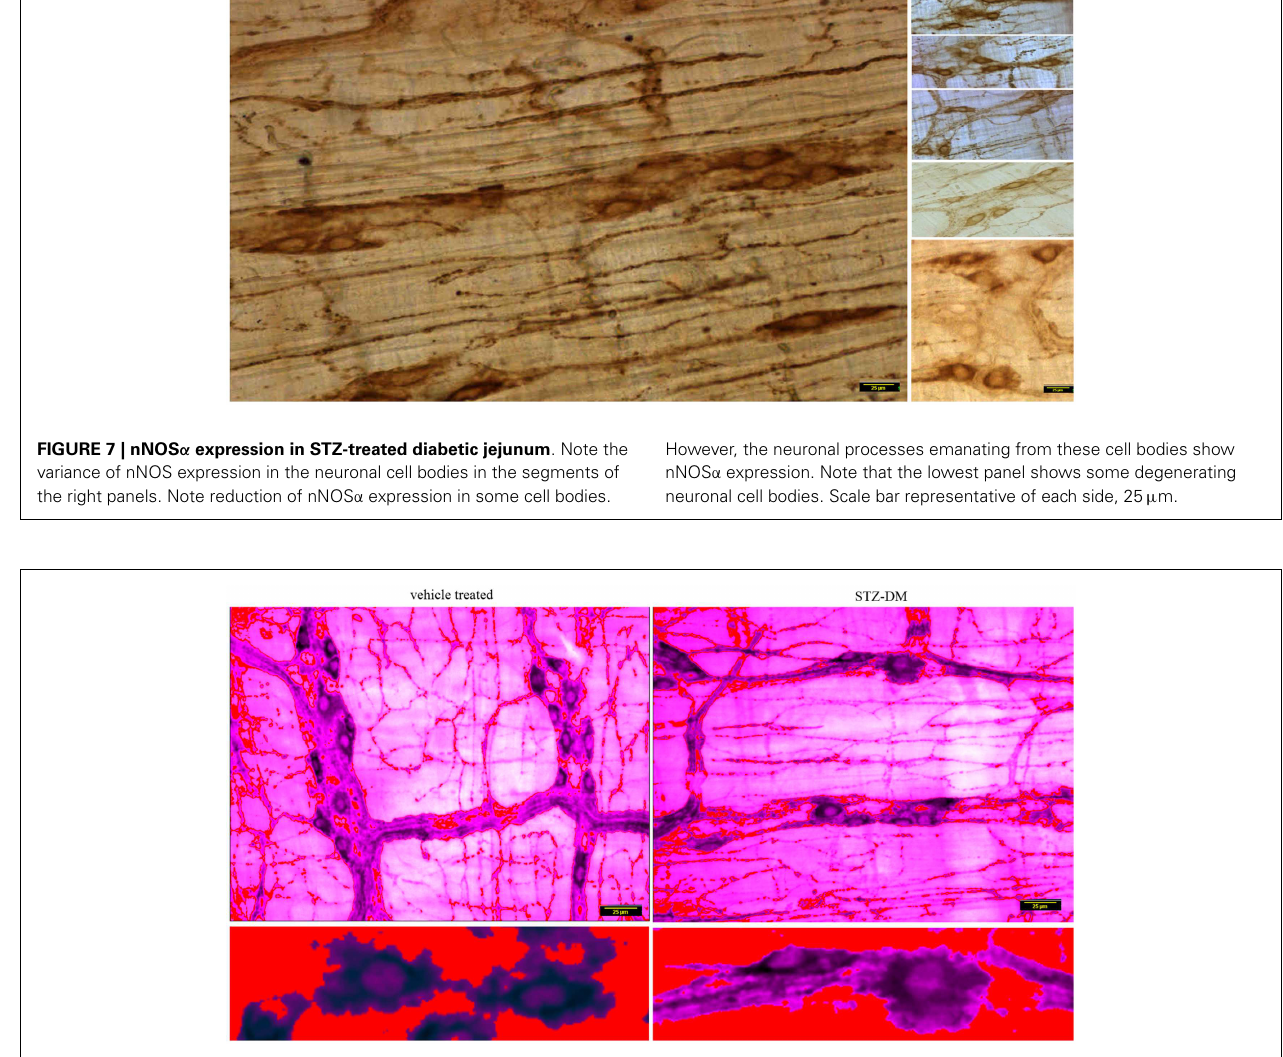
FIGURE 8 | Normal staining of nNOS within dendritic processes of Dogiel type 1 neurons and interganglionic neuronal processes in both vehicle treated and STZ-induced diabetic jejunum .The lower panels show a digitally zoomed image showing that nNOS extends into